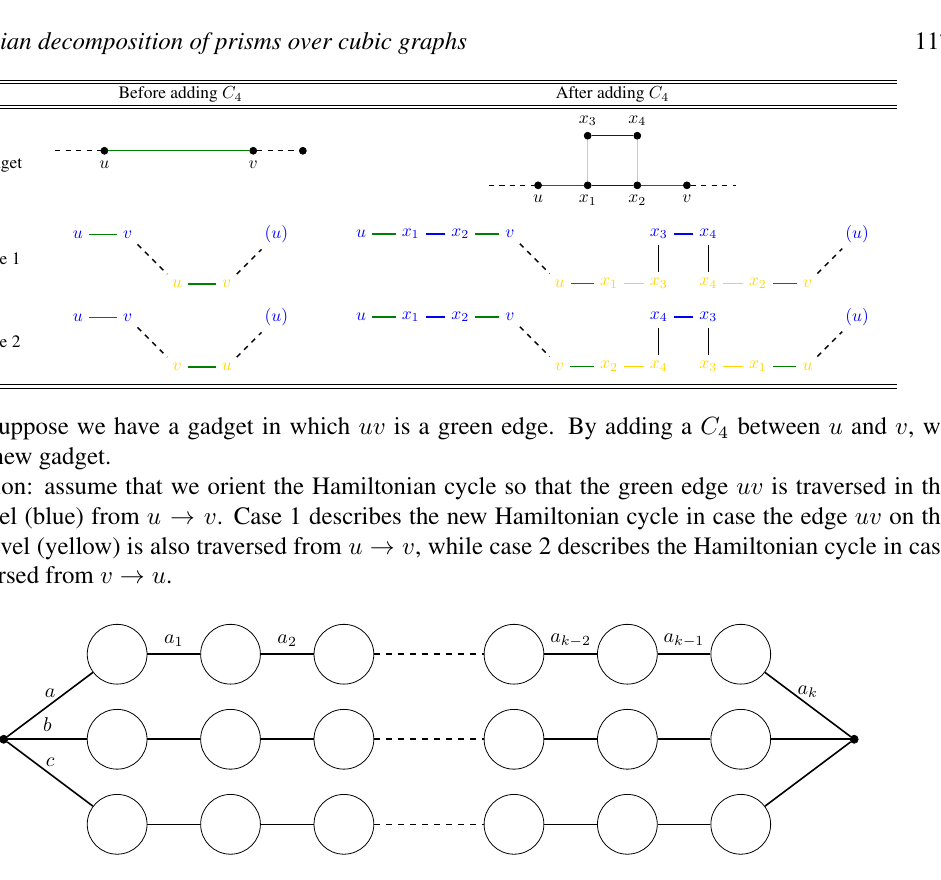
and similarly the paths starting at b and c . Prisms 1 , . . . a k